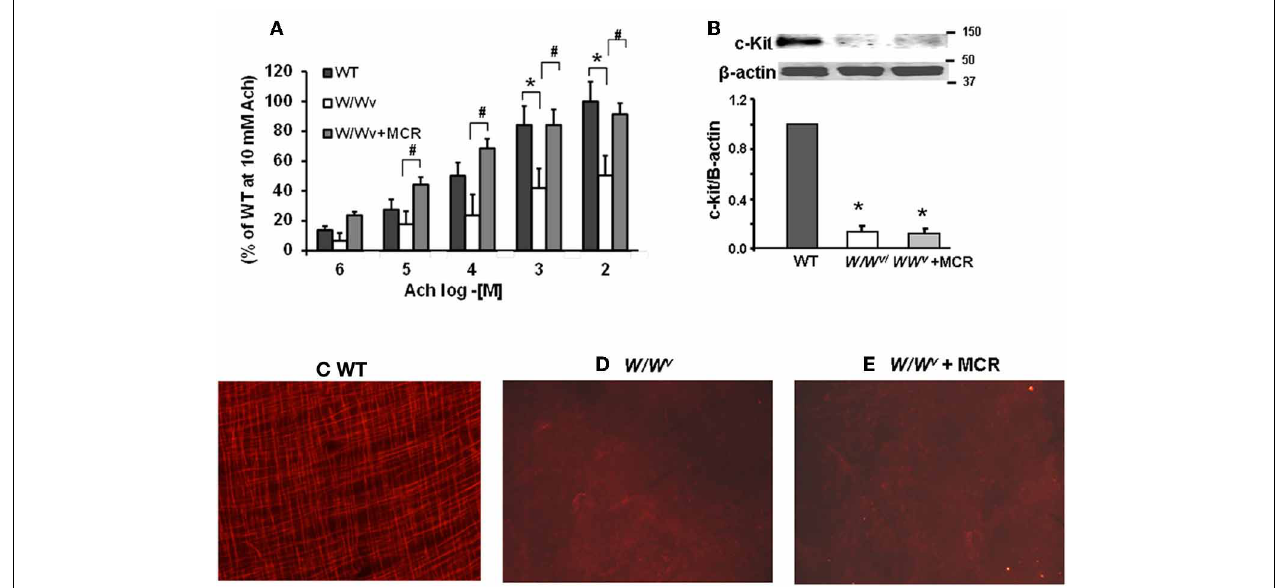
FIGURE 1 | Smooth muscle reactivity to Ach and c-kit expression in wild-type (WT), W/W v and W/W v mast cell reconstituted mice. (A) Bar graphs displaying the contractile response of fundus circular smooth muscle strips to increasing concentrations of Ach in wild type, W/W v , and W/W v with mast cell reconstituted mice. Smooth muscle reactivity to Ach was significantly lower in W/W v mice vs. the wild type mice ( ∗ p < 0 . 05) at Ach concentrations of 10 − 3 and 10 − 2 . Mast cell reconstitution restored smooth muscle reactivity to Ach. Smooth muscle reactivity to Ach was significantly higher in W/W